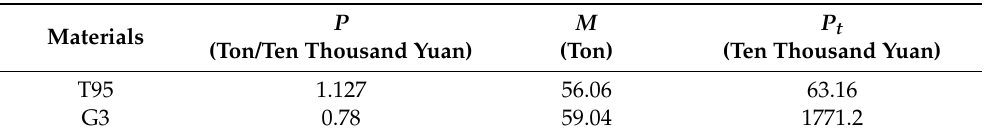
Table 4. Price of tubing with different materials for a single